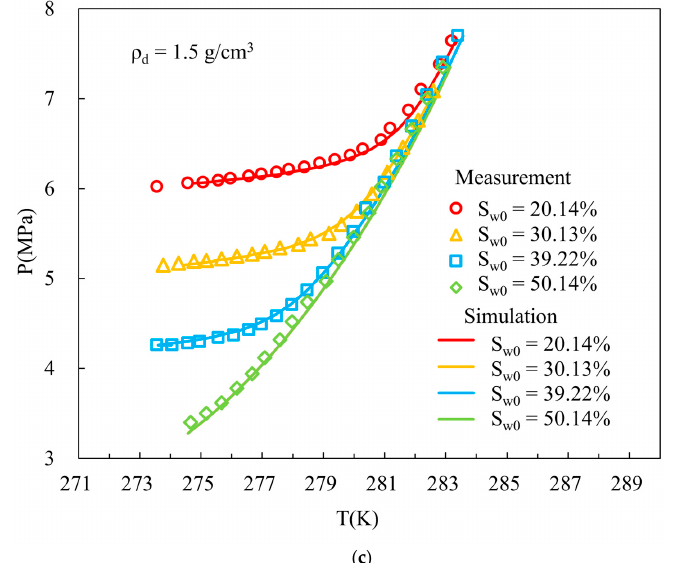
Figure 11. Comparison of simulation results of measured equilibrium conditions of methane hydrate phase in fine-grained sediment. ( a ) Low initial water saturation; ( b ) high initial water saturation; ( c ) different saturation at the same dry density.